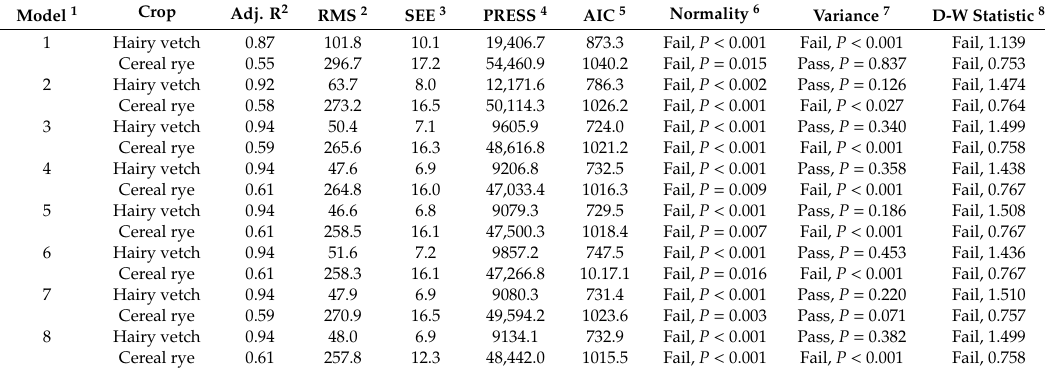
Table 8. Evaluation of models using combined data from Exp. 1 and 2 for percent mass remaining of aboveground hairy vetch and cereal rye cover crops in Carbondale,